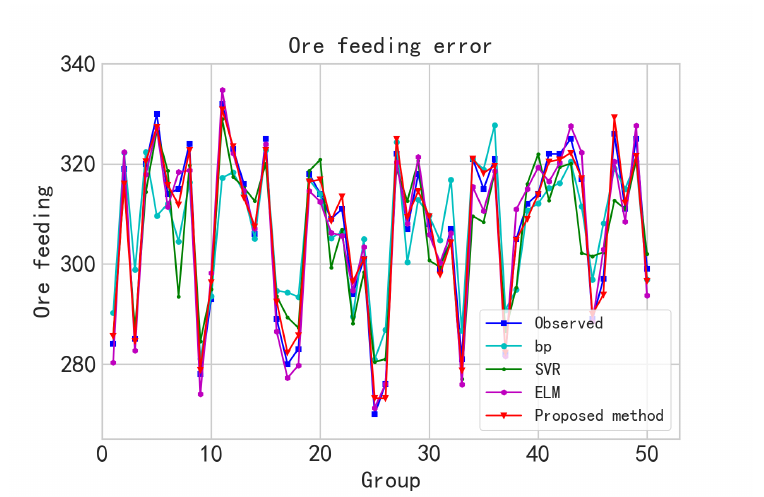
Figure 7. Comparison of different methods for ore feeding.